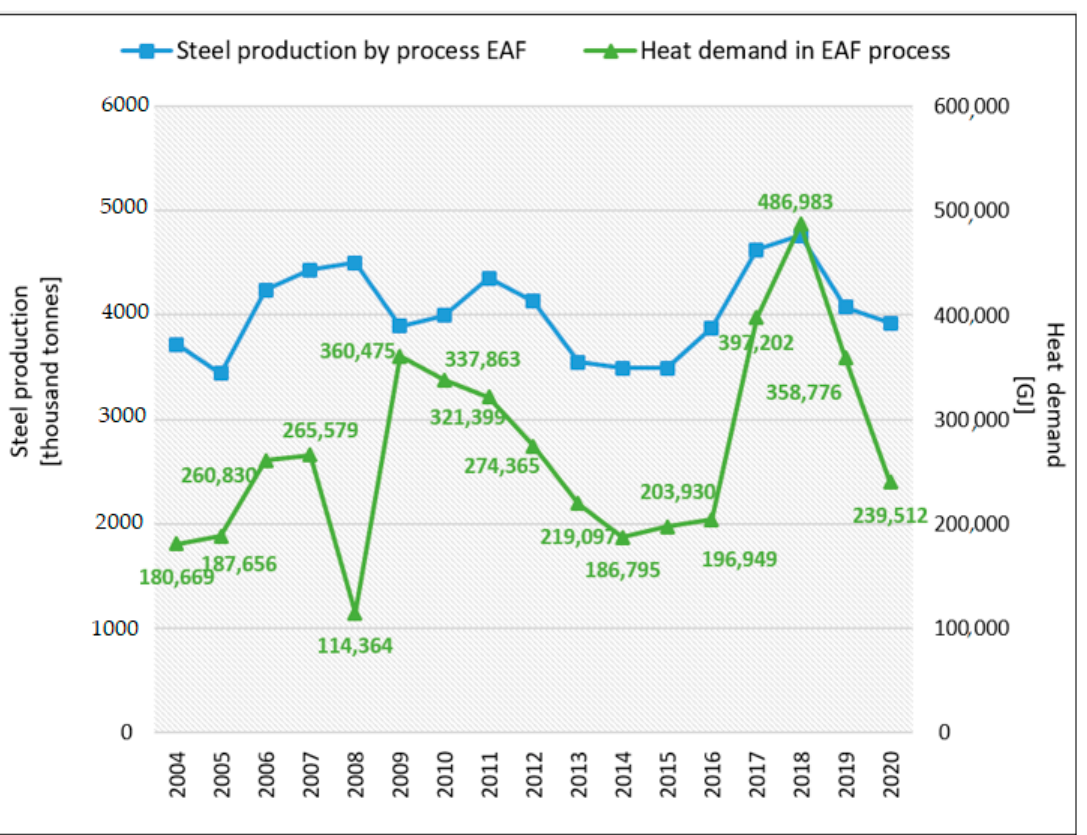
Figure 5. Total heat demand in the EAF process in Poland from 2004 to 2020. Source: Own elabora- tion.